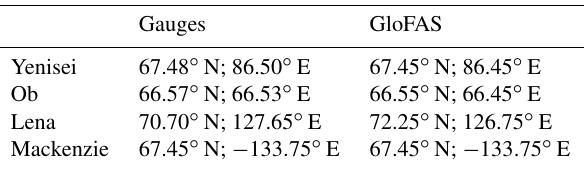
Table 1. Positions of gauge observations and GloFAS locations for Ob, Yenisei, Lena, and